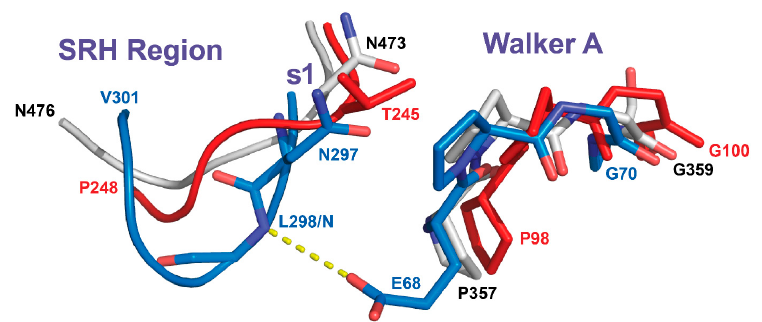
Figure 13. Loop comprising the SRH region (shown as a ribbon) with the s1 residue and the Walker A motif (both shown in sticks and marked). Disposition of the two fragments comprising the SRH region and the Walker A motif in Bs LonBA (red), Ec LonA (white), and Ton LonB (blue) is compared.